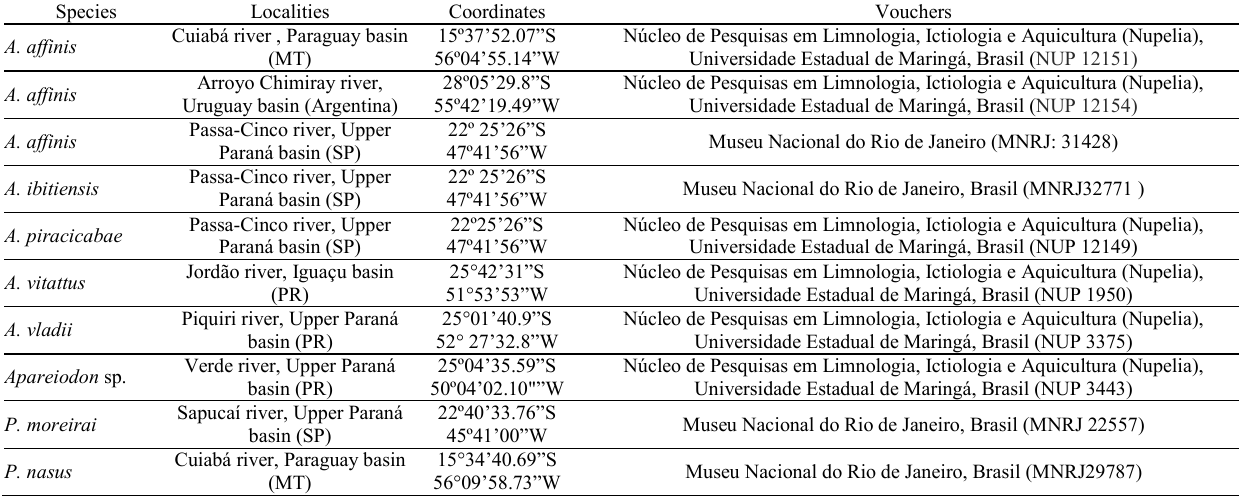
Table 1. List of specimens used in barcoding analyses and their collection data.